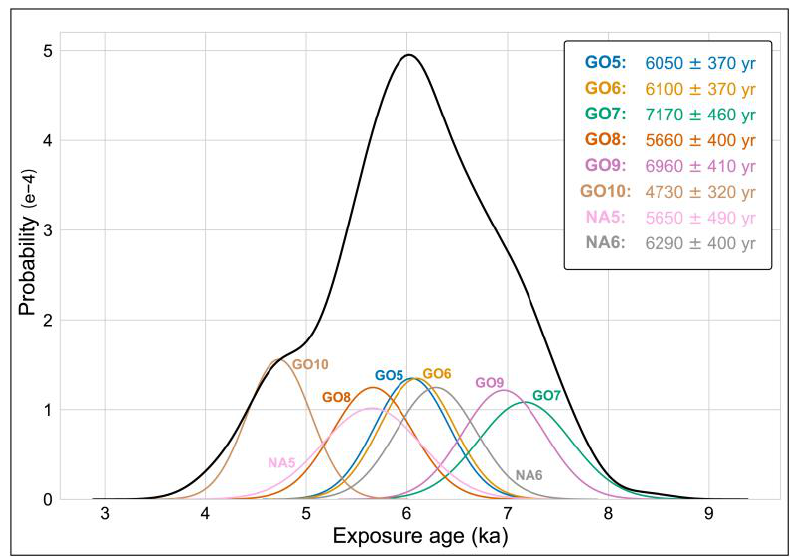
Figure 12. Camel plot for the eight 36 Cl exposure ages for boulders from the Gorte rock avalanche deposits. Colored lines show individual exposure ages and the Gaussian distribution of the uncer- tainties. The black line indicates the summed probability distribution for the dataset. The mean of the ages is 6.1 ± 0.8 ka.